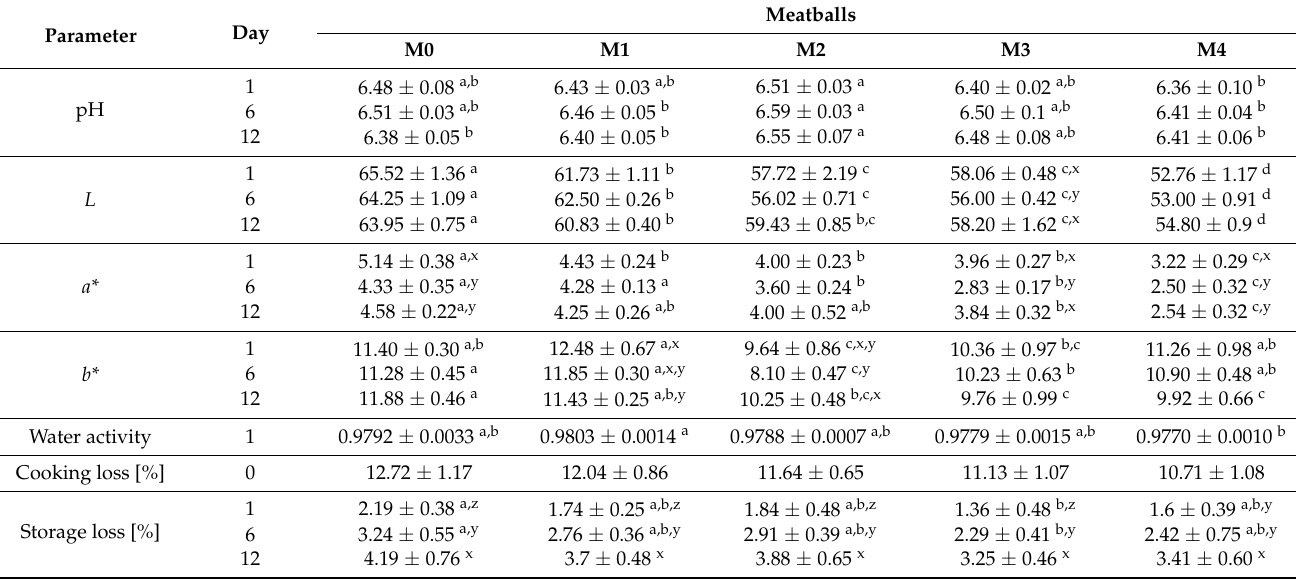
Table 3. Physicochemical properties of cooked meatballs measured during storage; mean ± SD.